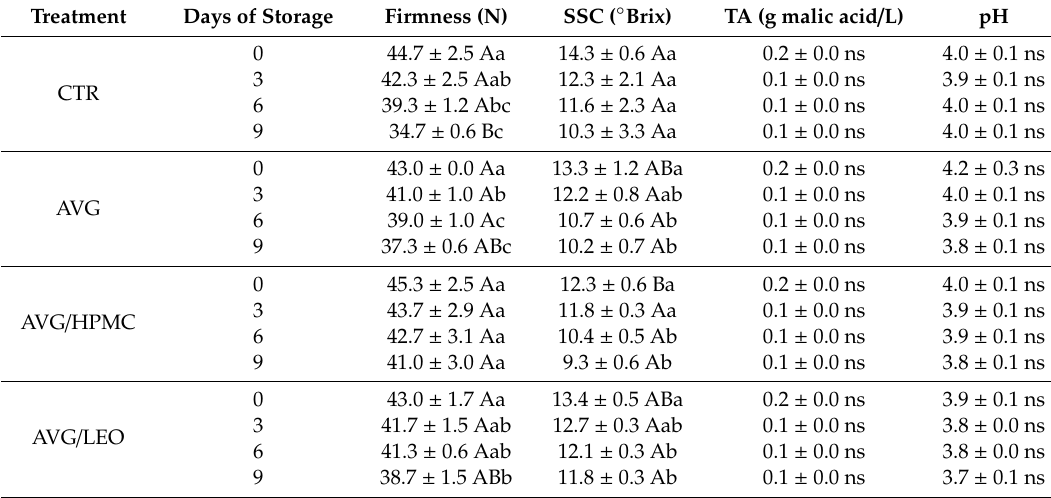
Table 2. Physico-chemical traits of fresh-cut apples at 0, 3, 6, and 9 days of storage at 4 ◦ ± 1 ◦ C and 90% ± 5% RH after all